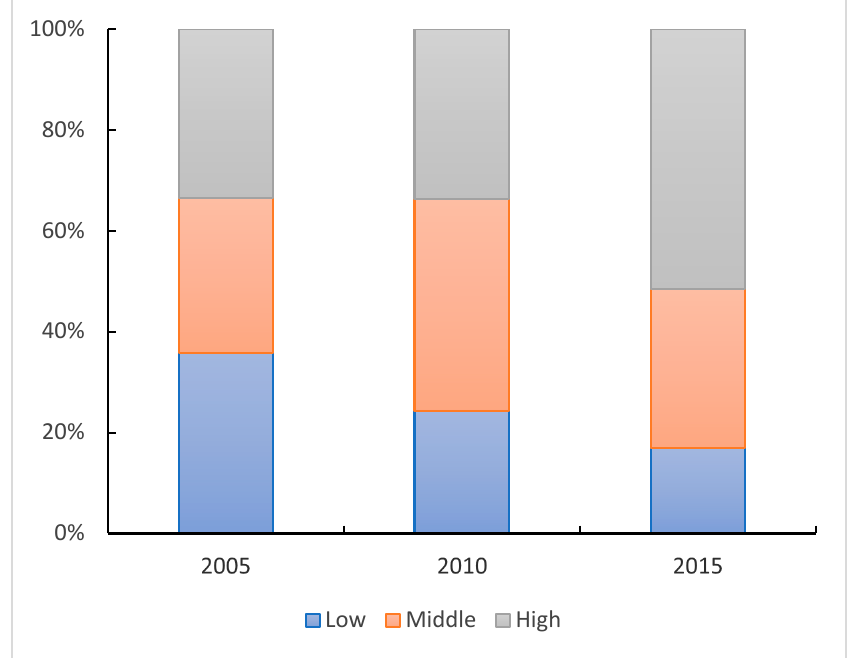
Figure 9. The area of each level of NPP in 2005, 2010, and 2015.